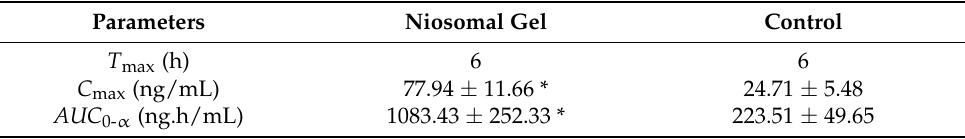
Table 3. Estimated pharmacokinetic parameters of levosulpiride in plasma after transdermal adminis- tration in Wistar rats. Each value depicts the average and standard deviation of six different